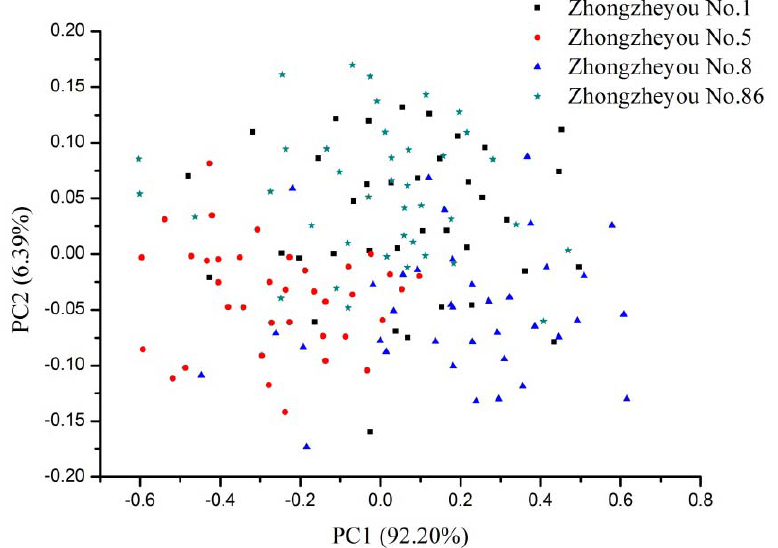
Figure 3. Scores scatter plot of PC1 and PC2 of raw spectra.